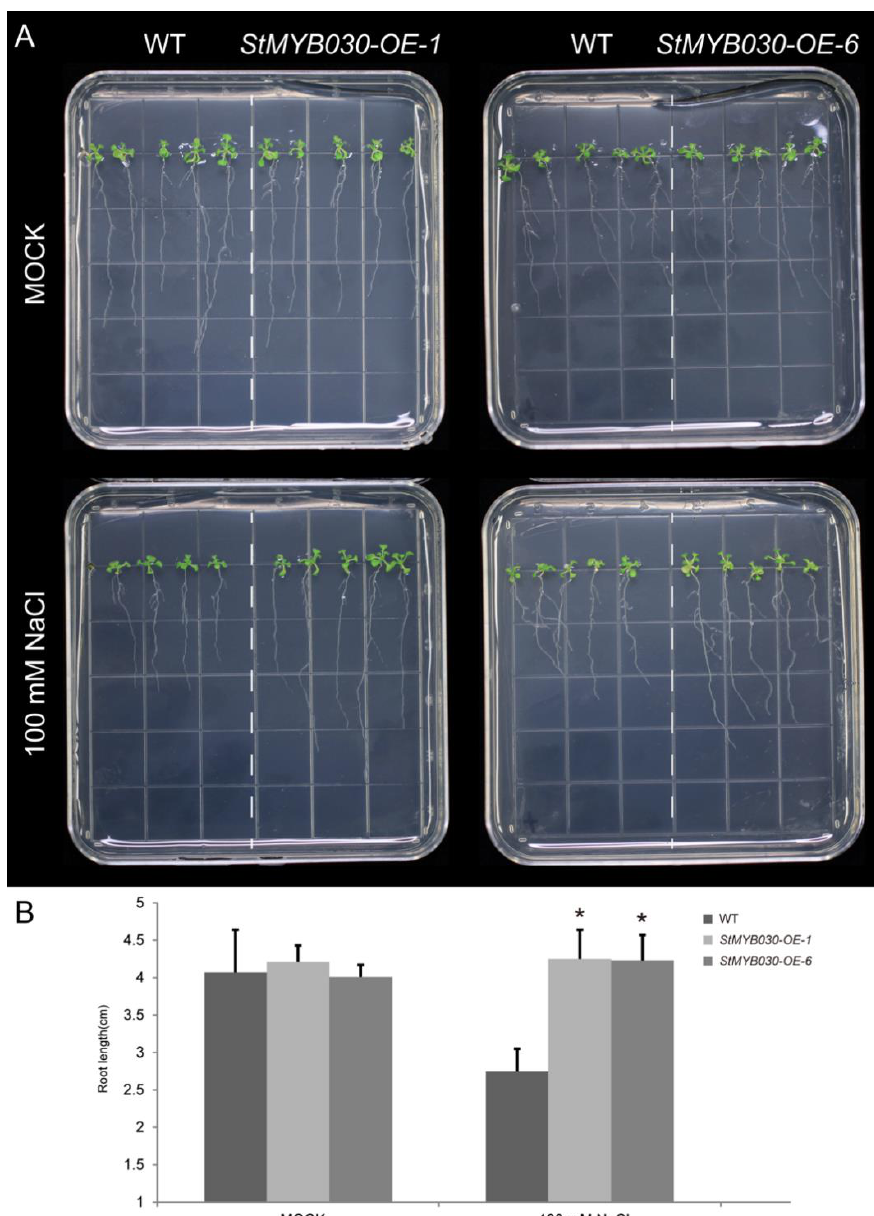
Figure 11. The Effects of salt stress treatment on root growth of StMYB030 gene overexpressing lines in transgenic Arabidopsis . ( A ) The primary root length of wildtype and StMYB030 gene overexpression lines under salt treatments in transgenic Arabidopsis . ( B ) The quantification of primary root length under normal condition and 100 mM NaCl treatments. The data were retrieved from three biological replicates. WT, wildtype. The data were means ± SD of three biological repeats. * p < 0.05 ( t -tests).